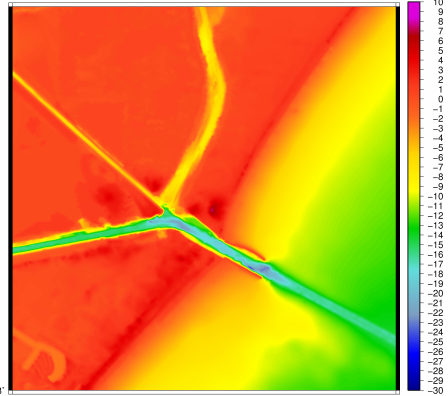
Figure 3. Current bathymetry.